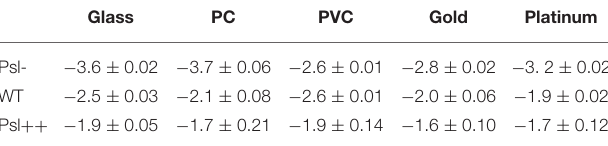
on the five chosen ++